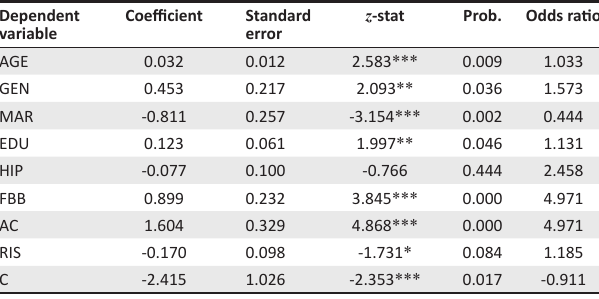
TABLE 3a: Logistic regression